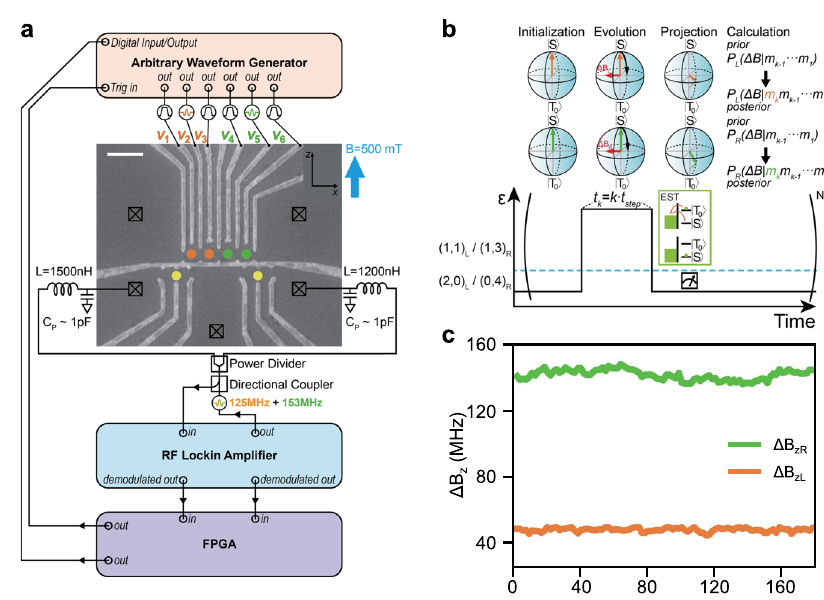
Fig. 1 Experimental setup. a A schematic of the experimental setup. Yellow circles indicate the RF single-electron transistors for dual RF re fl ectometry. Orange (green) circles indicate QDs for the left (right) ST 0 qubit (Q L and Q R ). The plunger and barrier gates are connected to the arbitrary waveform generator for the application of detuning and RF pulses. The white scale bar corresponds to 500 nm. b Schematic diagram of the dual Hamiltonian estimation of the fi eld gradient Δ B L and Δ B R . See main text for the estimation procedure. The green box shows the energy selective tunneling-based single-shot readout method. c The example traces of the simultaneously estimated fi eld gradient Δ B of each qubit as a function of